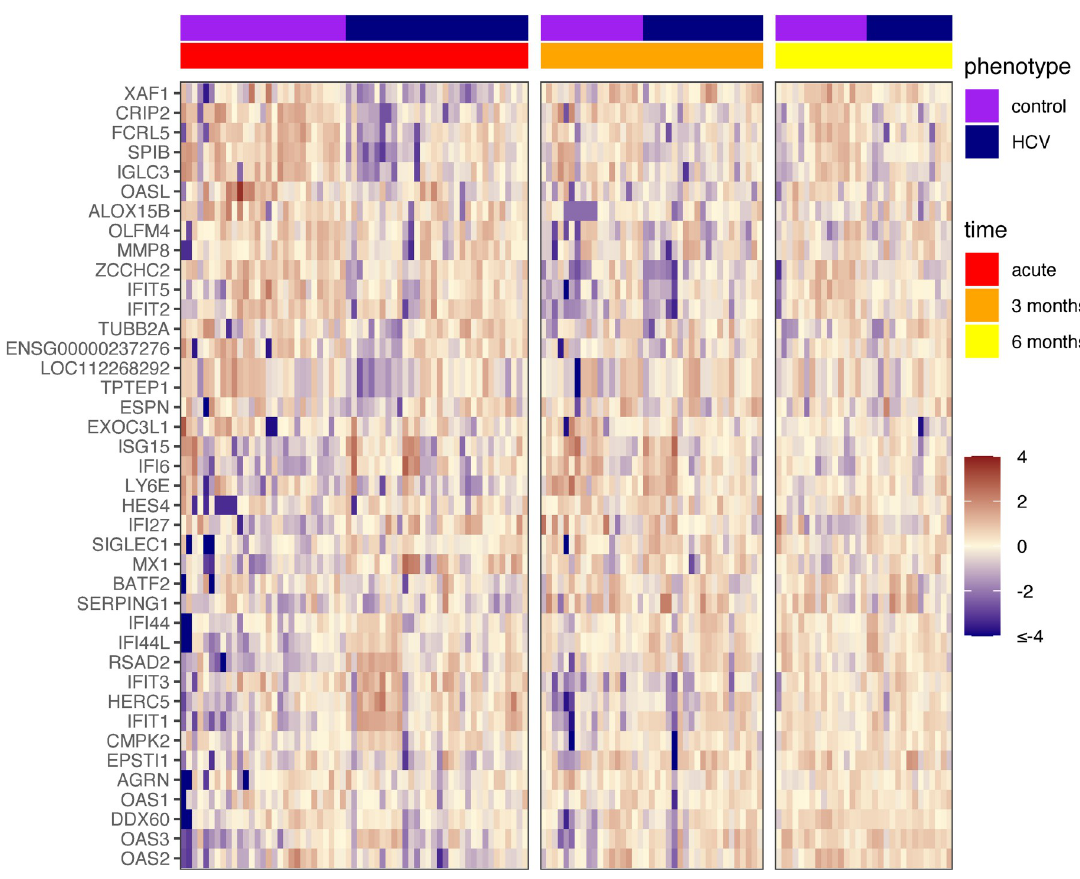
Fig 2. Heatmap of HCV vs control samples at acute, 3-month, and 6-month timepoints. The list along the y-axis includes all transcripts with |log fold changes| � 1 comparing HCV and control samples. Gene names are sorted using a clustering algorithm to group the genes based on expression, combining those that are most similar. Differences in gene expression are noted at the acute timepoint between HCV and control samples, that decrease and resolve by the later timepoints.